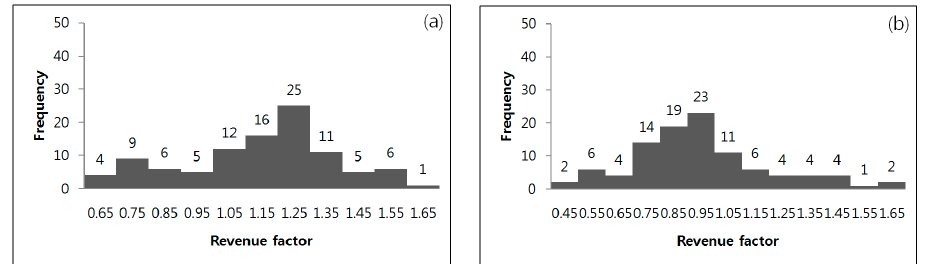
Figure 7. Results from revenue factor calculation. ( a ) Histogram of revenue factors related to copper prices; ( b ) Histogram of revenue factors related to zinc prices.